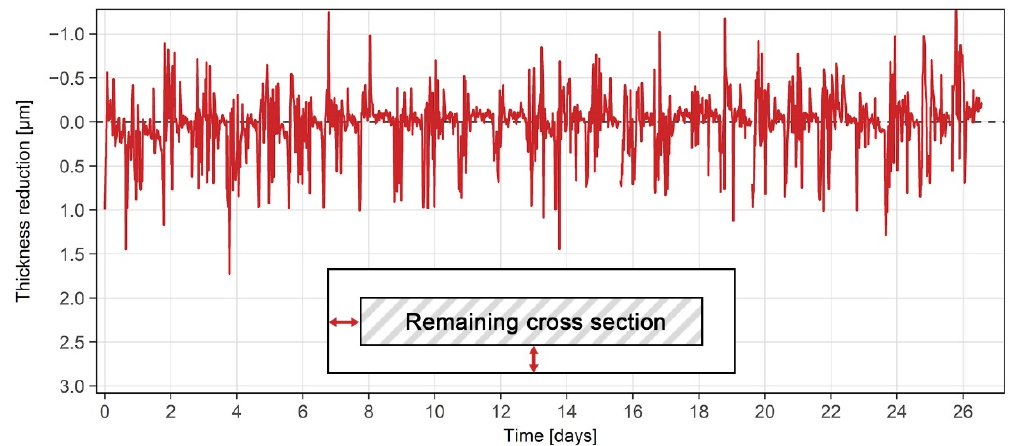
Figure 11. Reduction in thickness of the grade 2507 ER sensor under industrial conditions.